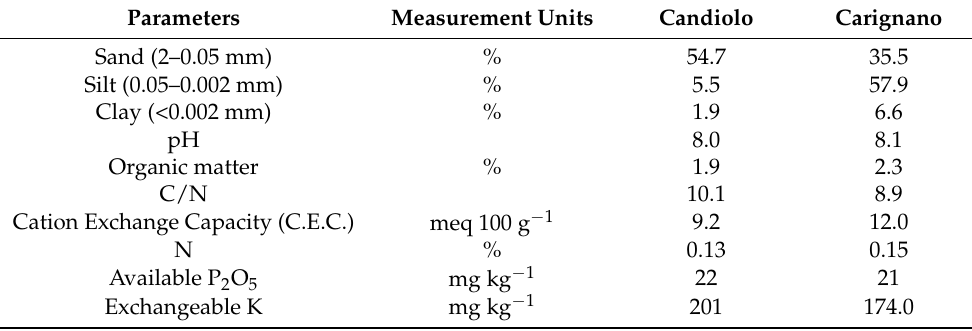
Table 1. Main physical and chemical characteristics of the experimental